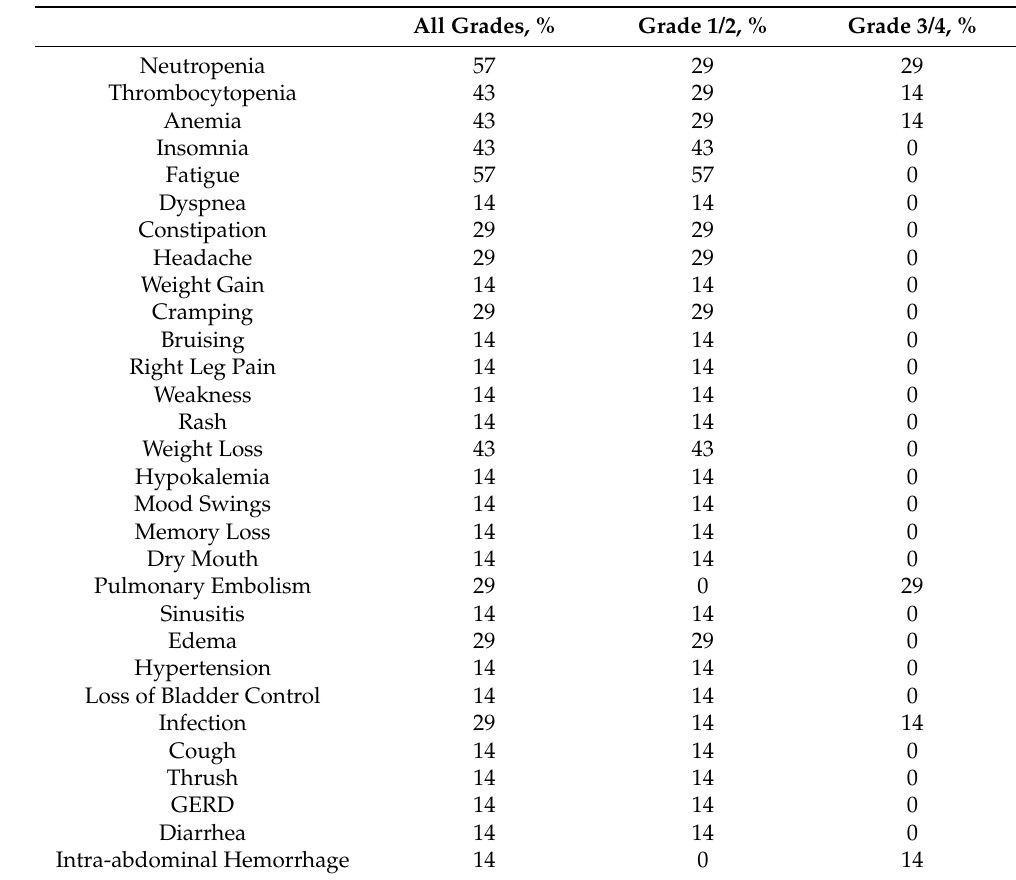
Table 4. Adverse